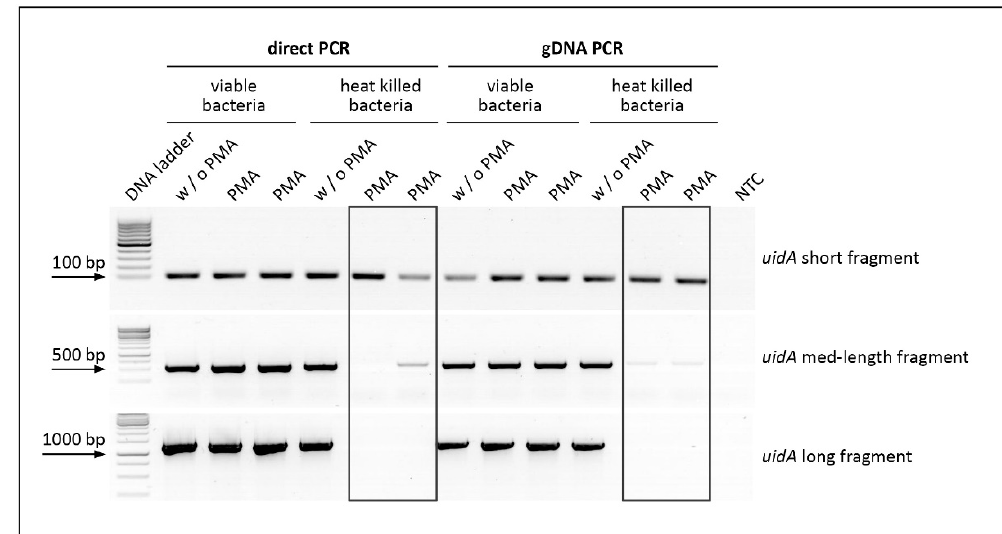
Figure 3. Impact of different fragment lengths on signal reduction of heat killed cells, displayed on an analytical agarose gel. Viable and heat killed E. coli cells were treated with or without (w/o) PMA. Direct PCR or classical PCR was performed using isolated gDNA as a template with three different primer pairs for three different target regions of the uidA gene (long 1370 bp, medium 556 bp, short 96 bp). Two independent PMA-treatments and PCR amplifications were performed for each condition. The No Template Control (NTC) includes all PCR reagents except for DNA.